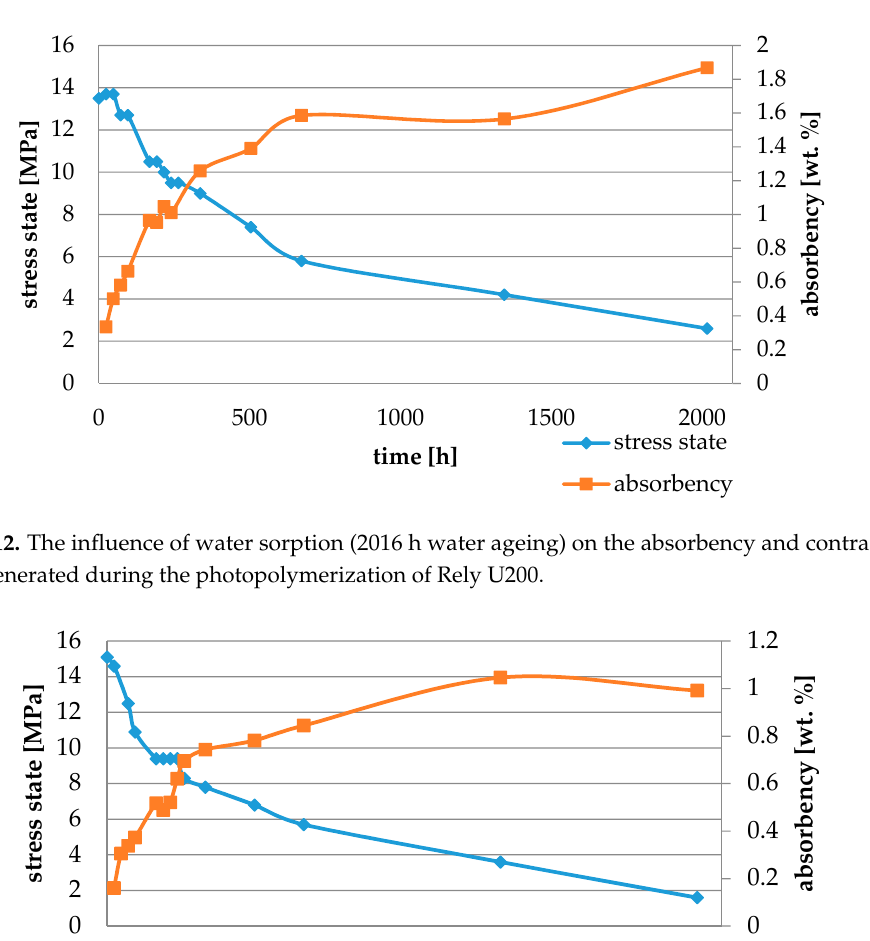
Figure 11. The influence of water sorption (2016 h water ageing) on the absorbency and contraction stress generated during the photopolymerization of Panavia SA Plus.